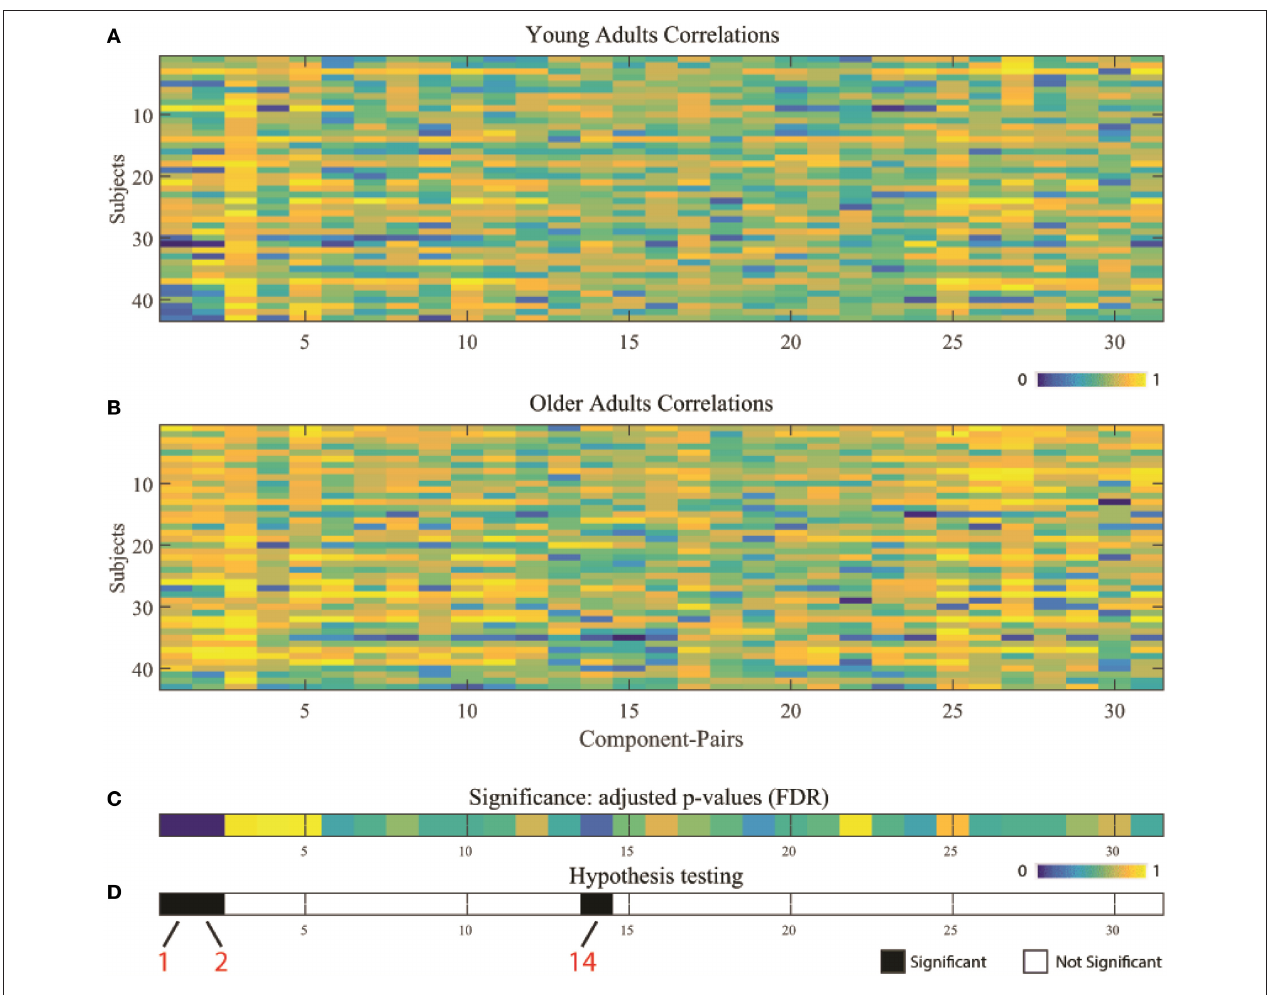
FIGURE 4 | Component-pairs correlation Pearson’s rho values for individual subject by population group: (A) young adults, and (B) older adults. (C) Illustrates results from two-sample t -tests between the two age groups across the 31 overlapping high-correlation component-pairs, corrected for multiple comparisons using FDR correction. (D) Presents the results of the hypothesis testing, with black illustrating significant differences (white = non-significant) between the two different age groups. Component-pairs 1 (V2–V1), 2 (V2–V4), and 14 (aDMN–pDMN) exhibited statistically significant differences. ( V1, visual area 1 component; V2, visual area 2 component; V4, visual area 4 component; aDMN, anterior DMN component; pDMN, posterior DMN component)